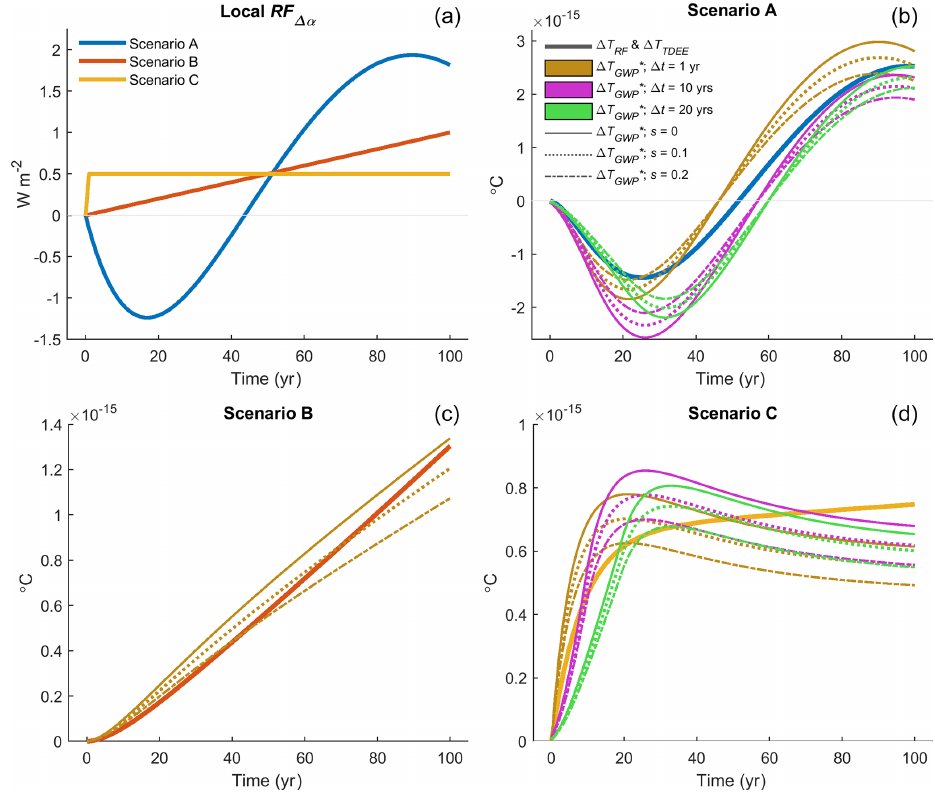
Figure 7. Performance of GWP ∗ computed for three stylized scenarios of surface-albedo-change-driven radiative forcing using Eq. (10) with nine different parameter sets. (a) Local radiative forcing of one permanent and two temporally evolving surface albedo change scenarios. (b– d) The corresponding global mean temperature response (cid:49)T to the radiative forcing relative to that which has been reconstructed using the CO 2 -eq . emission (removal) time series computed with T DEE and GWP ∗ under the assumption that (cid:49)α t + n − t is known. (cid:49)T in panels (b– d) is estimated with a temperature impulse response function following Boucher and Reddy (2008) and Myhre et al. (2013) having a climate sensitivity of 1.06K ( Wm − 2 ) − 1 , which is equivalent to a 3.9K equilibrium climate response to an abrupt CO 2 concentration doubling. Table 4. Differences in surface property and flux perturbations between geoengineering-type forcings involving non-vegetative solar radiation management (SRM) and forcings from LULCC, land management change (LMC), or forest management change (FMC). (cid:49)r a : change to bulk aerodynamic resistance; (cid:49)r s : change to bulk surface resistance; (cid:49)λ(E) : latent heat flux change from a change to evaporation; (cid:49)λ(E + T ) : latent heat flux change from a change to both evaporation and transpiration; (cid:49)H : sensible heat flux change. Forcing type Surface property